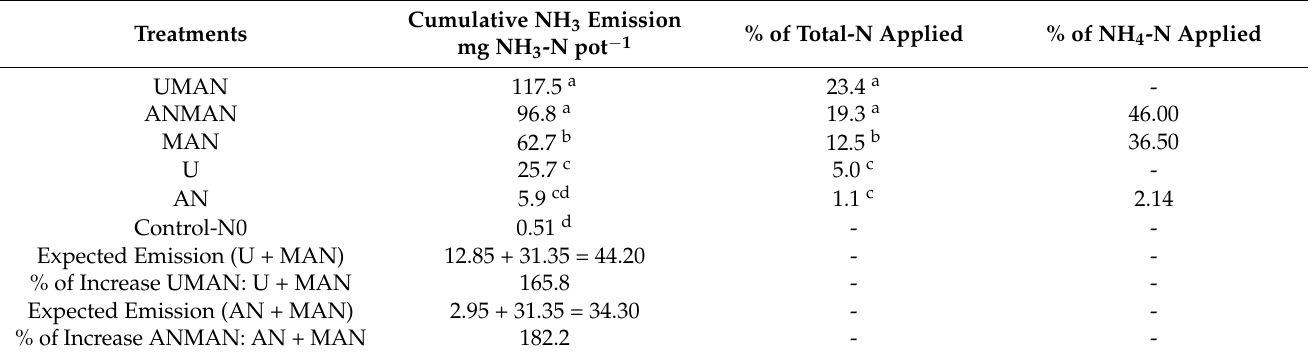
Table 3. Cumulative NH 3 emission (mg NH 3 -N pot − 1 ) as a percentage of total-N and NH 4 -N applied (excluded control emissions). The expected NH 3 -N emissions considering the contribution of 50% from each one of the components of the mixture (U + MAN or AN + MAN) and the percentage of observed emission increase compared to expected. Values followed by different letters, in the same column, are significantly different based on the LSD test (mean, n = 3).